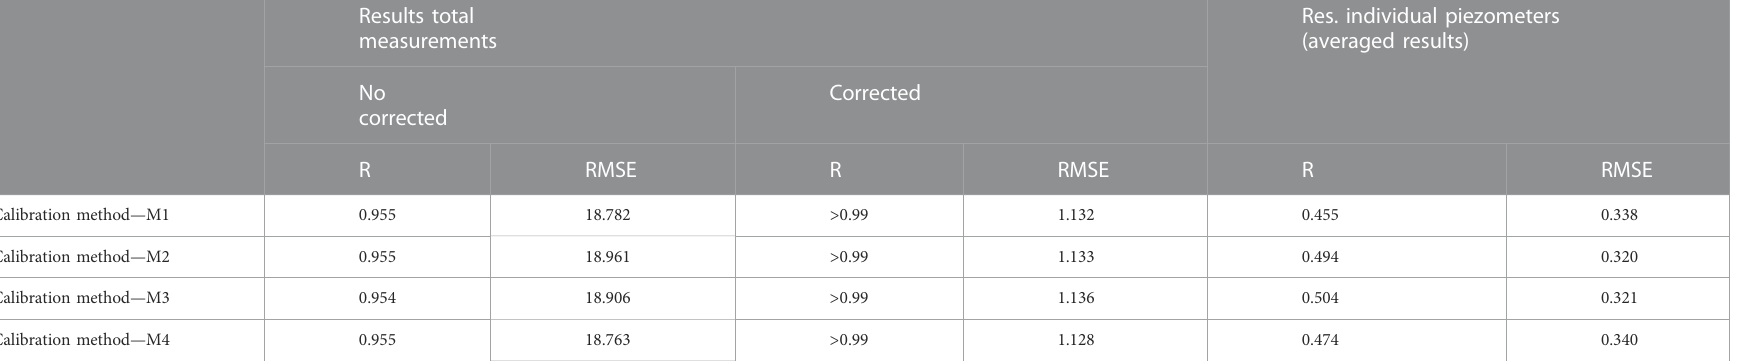
TABLE 2 Statistical results of the transient calibrations.